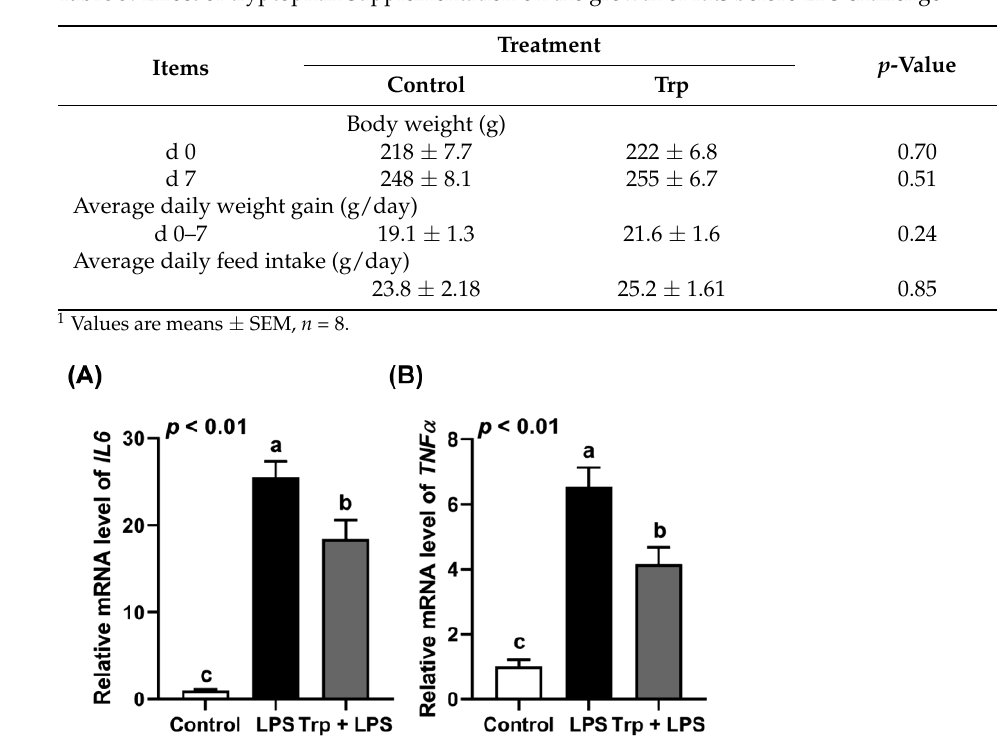
Figure 1. Effect of tryptophan supplementation on the expression of IL6 (A) and TNF α (B) in the jejuna of LPS-challenged rats. Values are means ± SEM, n = 6–8; a–c: values without a common letter jejuna of LPS-challenged rats. Values are means ± SEM, n = 6 – 8; a – c: values without a common letter differ ( p < differ ( p < 0.01).